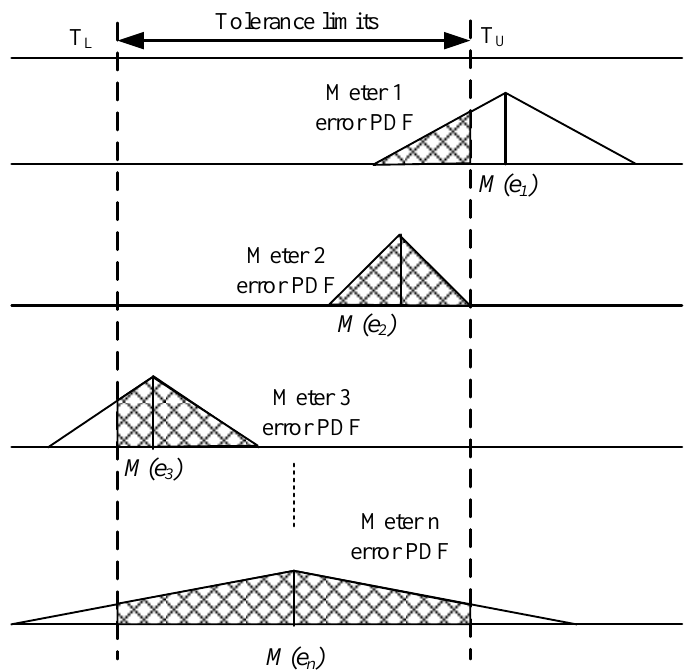
Figure 1. Experimental error probability density function (PDF) of meters in relationship to tolerance limits.